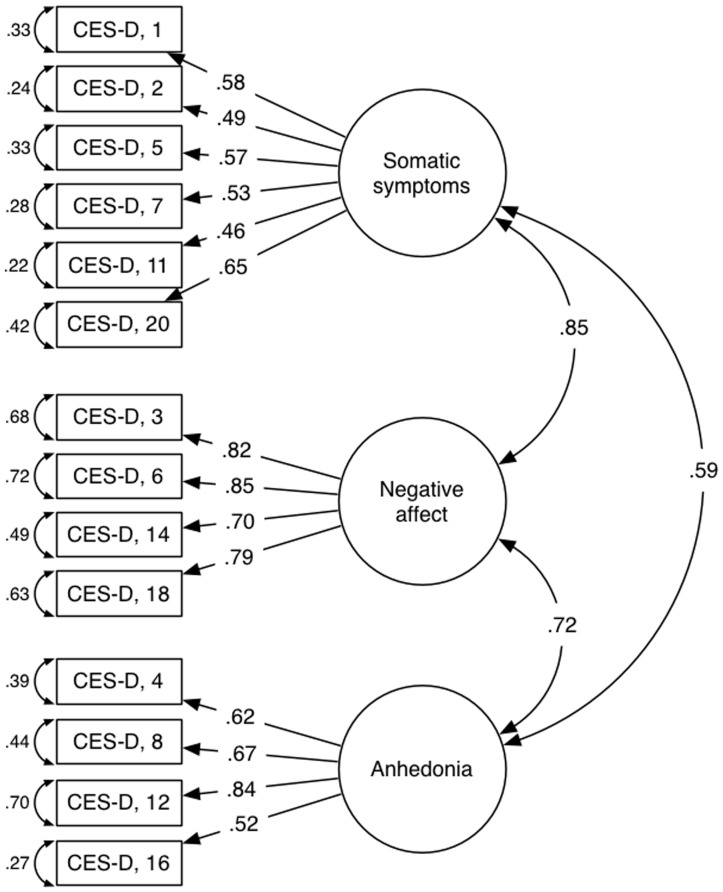
Path Diagram for the CES-D new factor solution.